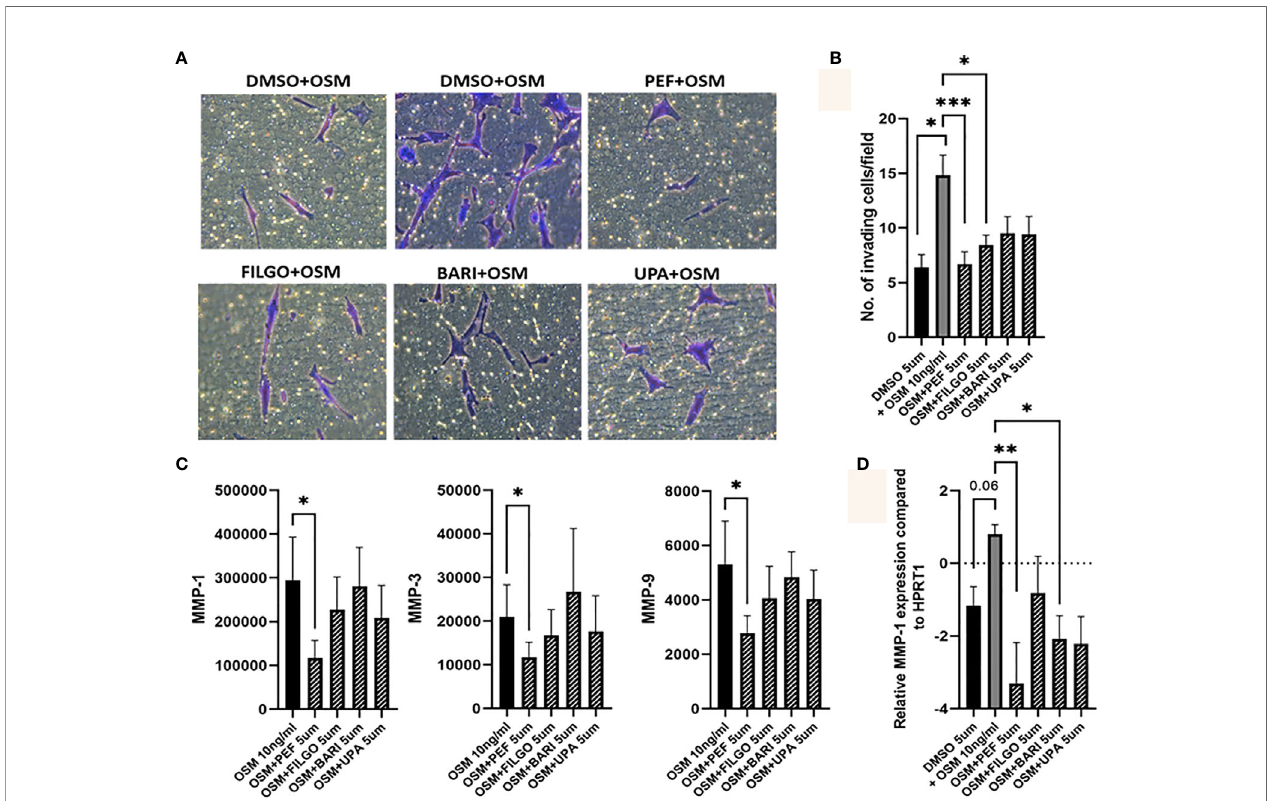
FIGURE 5 | OSM driven invasion by PsAFLS is blocked by JAKi. (A) Representative photomicrographs and (B) bar graph showing PsAFLS invasion following treatment with JAKi (5 µM) or DMSO (5 µM) for 1 hr and stimulated with OSM (10 ng/ml) for 24 h, n=6 (magni fi cation X20). (C) Representative bar graph showing MMP-1, MMP-3 and MMP-9 expression by MSD ELISA (n=7) and (D) gene expression analysis of MMP-1 by real-time PCR (n=5). Values expressed as the mean +/- SEM, * p <0.05, ** p <0.01, *** p <0.001 signi fi cantly different from DMSO+OSM